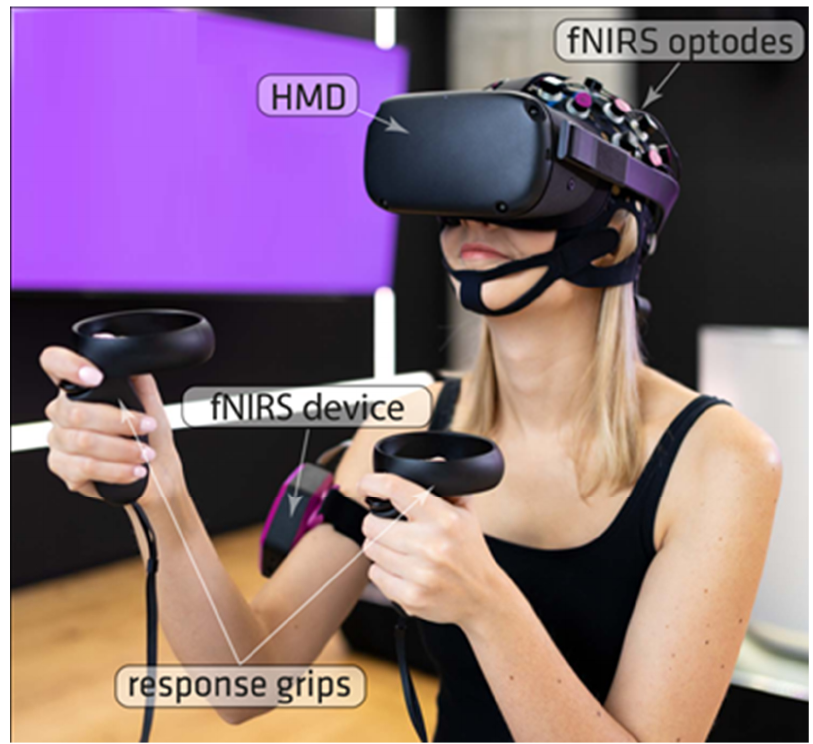
Figure 1. The experimental setup included wireless all-in-one VR goggles and a wearable fNIRS device. Participants were seated during data recording and the devices were not connected by a cable.